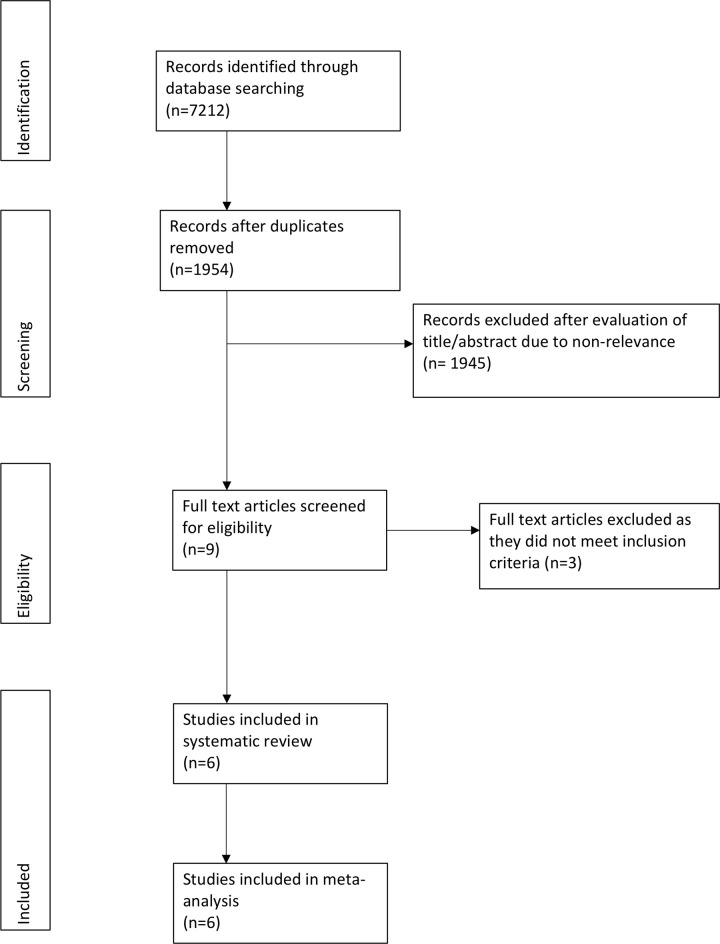
Study flow chart.